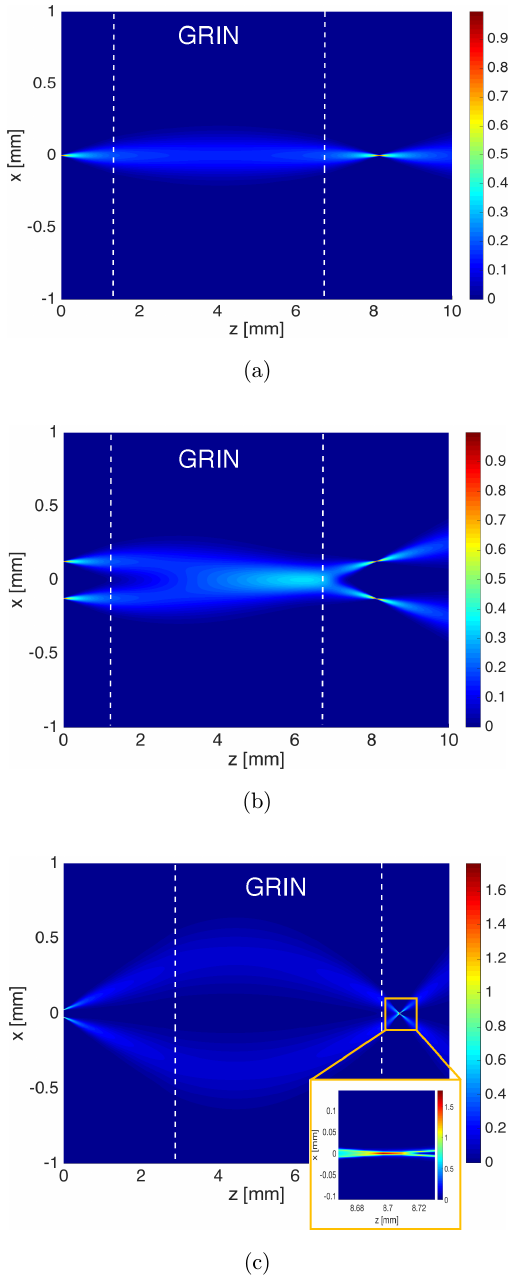
Fig. 5. Two-dimensional propagation modeling of Gaussian beams in a GRIN lens. (a) Single beam placed at the focal plane. (b) Two beams placed at the focal plane of the lens, but each shifted by 125 (cid:4) m vertically from the optical axis. (c) Two beams shifted from the focal plane and tilted by a 6 (cid:2) angle. The beams overlap area is 5 (cid:4) m (cid:4) 20 (cid:4) m. White dotted lines indi- cate the ends of the GRIN